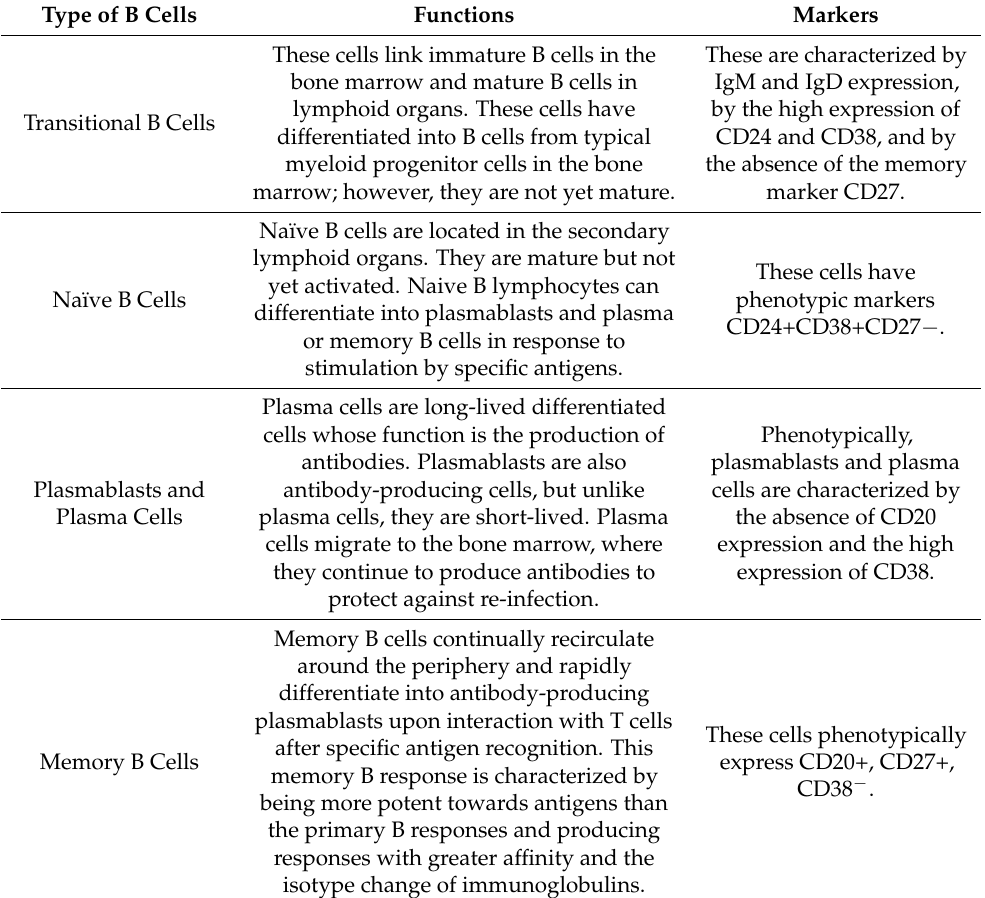
Table 1. Main B cells types, functions, and expression